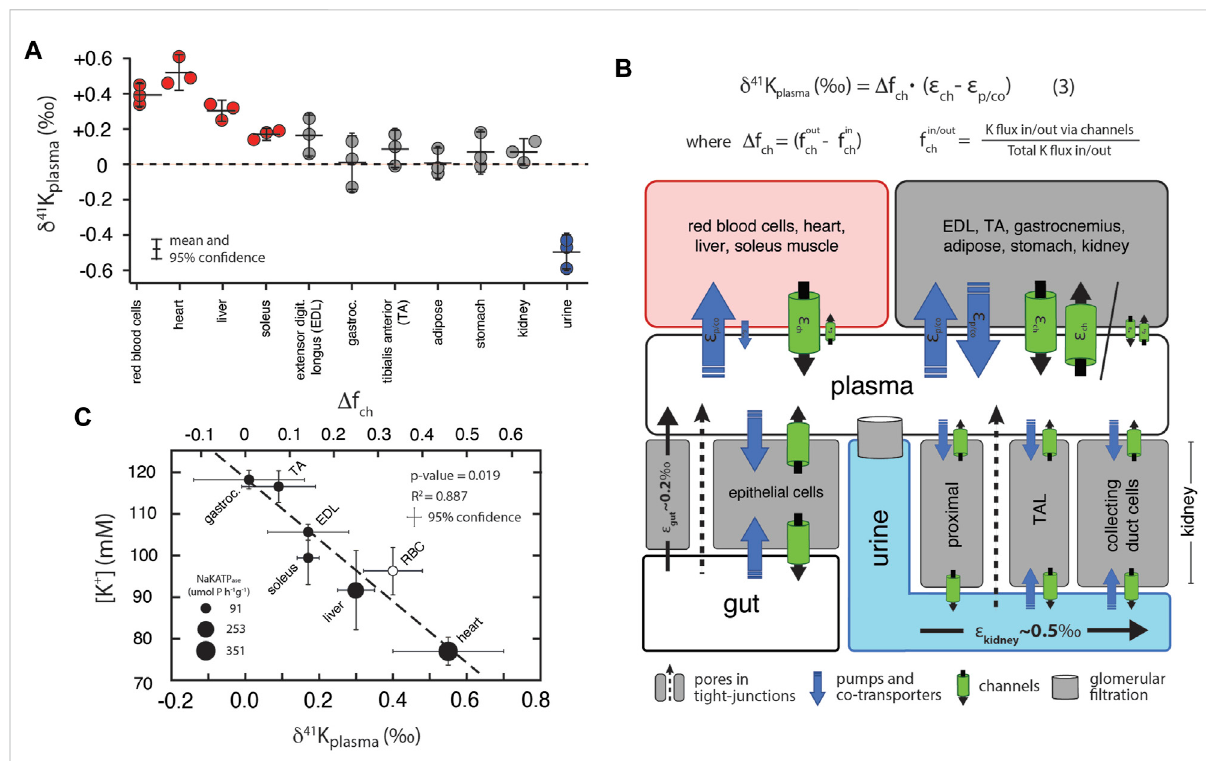
FIGURE 3 (A) K isotopic composition of tissues/ fl uids R. norvegicus (casein diet) normalized to plasma ( δ 41 K plasma = 0 ‰ ). δ 41 K plasma values that are positive indicate that net K + transport out of the tissue/cell/ fl uid is enriched in 39 K relative to K + transport into the tissue/cell/ fl uid. δ 41 K plasma values that are indistinguishablefrom0indicatethattheKisotopefractionationassociatedwithK + transportintoandoutofthecell/tissue/ fl uidareeither0orequal inmagnitude(andthuscancel). δ 41 K plasma valuesthatarenegativeindicatethatnetK + transportintothecell/tissue/ fl uidisenrichedin 39 Krelative to K + transport out of the cell/tissue/ fl uid. (B) A diagram of K isotope mass balance including transport by (1) K-channels, (2) K-pumps/co- transporters, (3) through pores in tight-junctions, and (4) glomerular fi ltration. Eq. 3 solves for the δ 41 K value of a tissue/cell relative to blood plasma assuming steady-state K isotope mass balance with bi-directional K + transport by both channels and pumps/co-transporters. Variables include f out/in ch , the fraction of total K + transport into/out of the tissue/cell that occurs through K + channels, Δ f ch , the difference in the fraction of K transport via channels(f out ch -f in ch ), ε ch ,KisotopefractionationassociatedwithKchannels,and ε p/co Kisotopefractionationassociatedwithpumps/co-transporters.K isotope fractionation associated with K + uptake inthegut ( ε gut )and K + loss in urine ( ε kidney )re fl ect the fl ux-weightedaverage ofboth paracellular and transcelluar K + transport. For example, K isotope fractionation in the kidney will be associated with both re-absorption and secretion of K + in the proximaltubule,thethickascendinglimb(TAL),andcellsinthecollectingductsofthekidney. (C) Correlationbetweenintercellular[K + ]and δ 41 K plasma values for a subset of tissues from R. norvegicus . Also shown are the measured activities of NaKATPase (µmol P h − 1 g − 1 from Gick et al., (1993) and values of Δ f ch from Eq.